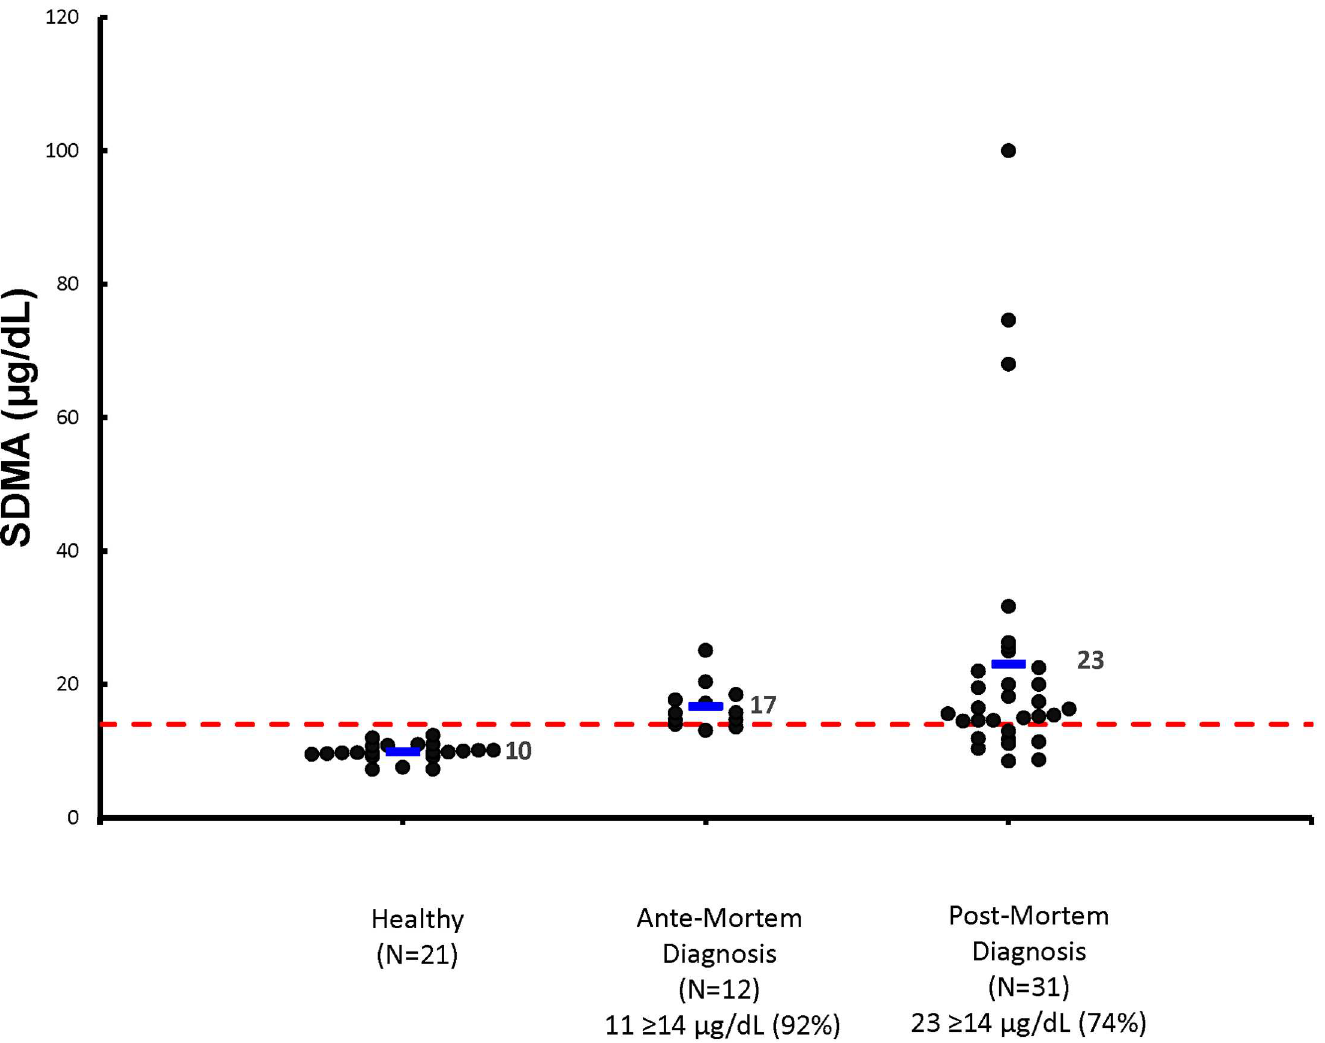
Fig 1. Serum SDMA concentrations are illustrated for healthy cats, cats with kidney stones diagnosed antemortem at the time of diagnosis, and cats with kidney stones diagnosed postmortem at the time of death. The dashed horizontal red line represents the upper limit of the reference intervalfor serum SDMA concentration ( < 14 μ g/dL). Individual cats in each group are representedby a black dot. The horizontalblue line represents the mean serum SDMA concentration for the group. The numberand percent of cats (cid:21) 14 μ g/dL in each group are also indicated.